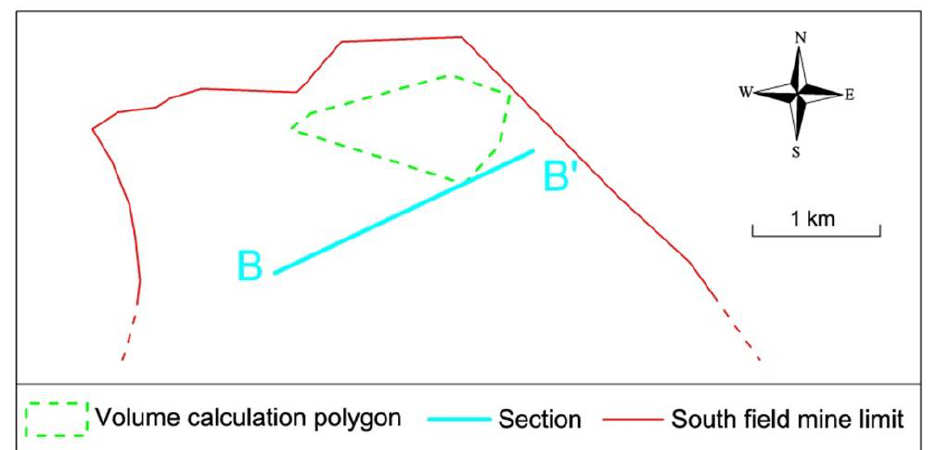
Figure 13. Volume calculation polygon and location of cross-section B–B’.